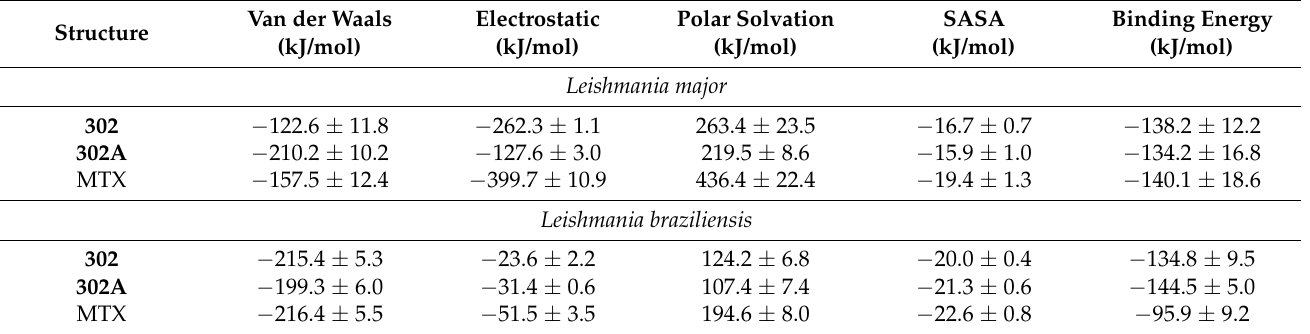
Table 4. Binding free energies (kJ/mol) from the MM/PBSA calculations for structure 302 and its derivative 302a for L. major DHFR-TS and L. braziliensis DHFR-TS; In both proteins MTX was used as reference